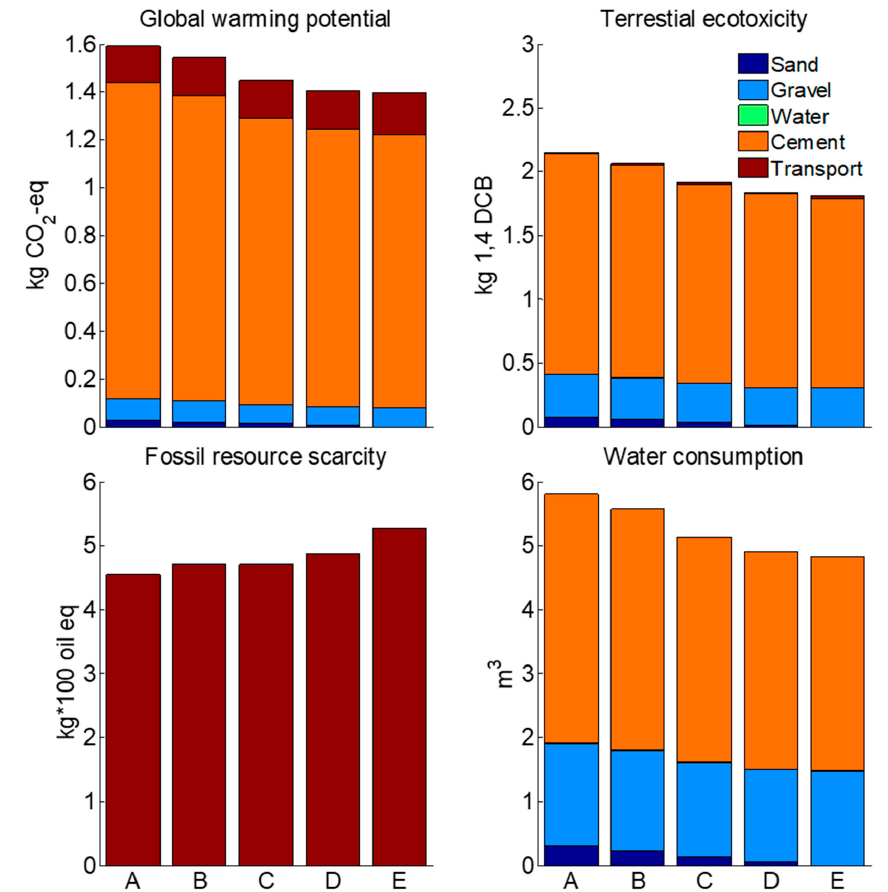
Figure 3. Environmental impacts of replacing sand with coal bottom ash (CBA): A—CBA0, B—CBA25, C—CBA50, D—CBA75, and E—CBA100. The environmental impacts were